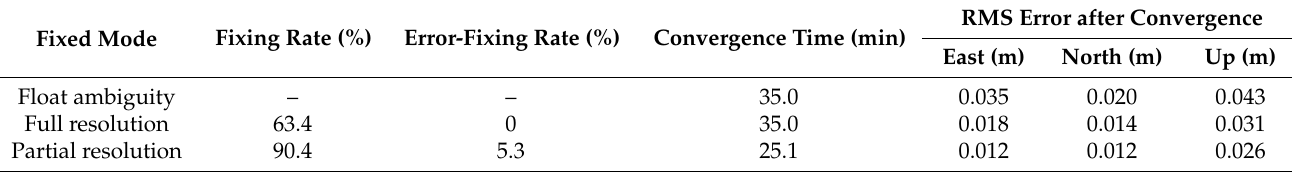
Table 5. Statistical results for GPS L1 + Galileo E1